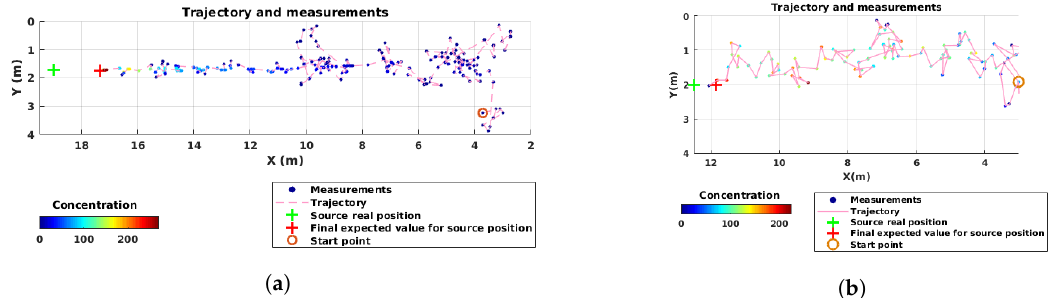
Figure 11. Two examples of the robot’s trajectory in the local framework: ( a ) simulation; and ( b ) wind tunnel. The initial position of the robot is shown with an orange circle; the actual source position (green cross) as well as its estimated location (red cross) are also indicated. On each sampled point, the measured concentration is indicated by the color of the circle, which corresponds to the averaged value of the measurements in a 5-s time window. The measured concentrations are relative values given by the sensor in mV .